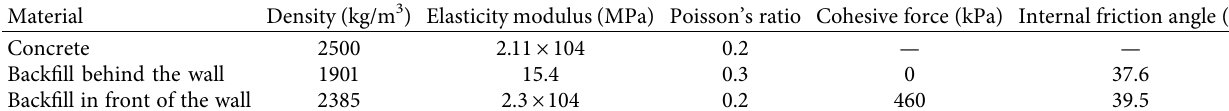
Table 3: Material parameters of the concrete and backfill.